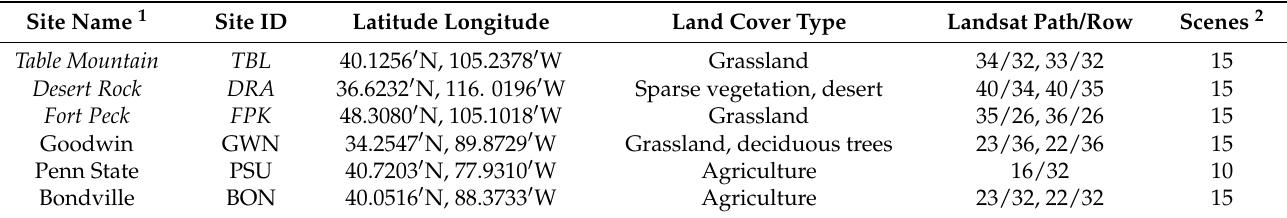
Table 1. SURFRAD ground stations